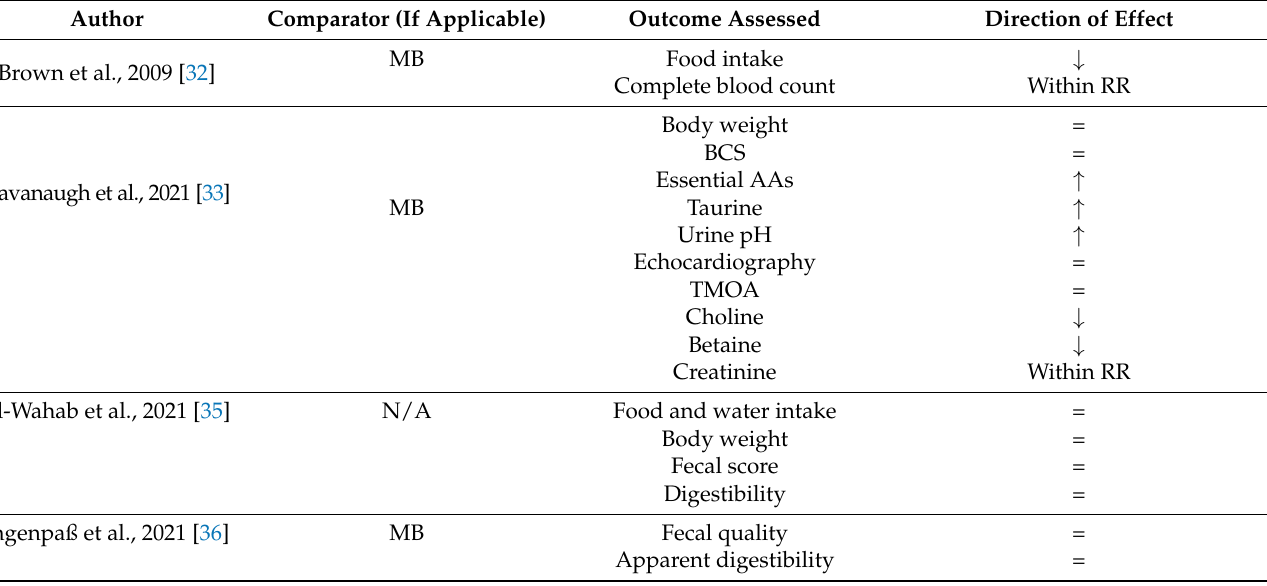
Table 3. Direction of effect for health parameters in dogs fed vegan diets compared to meat-based